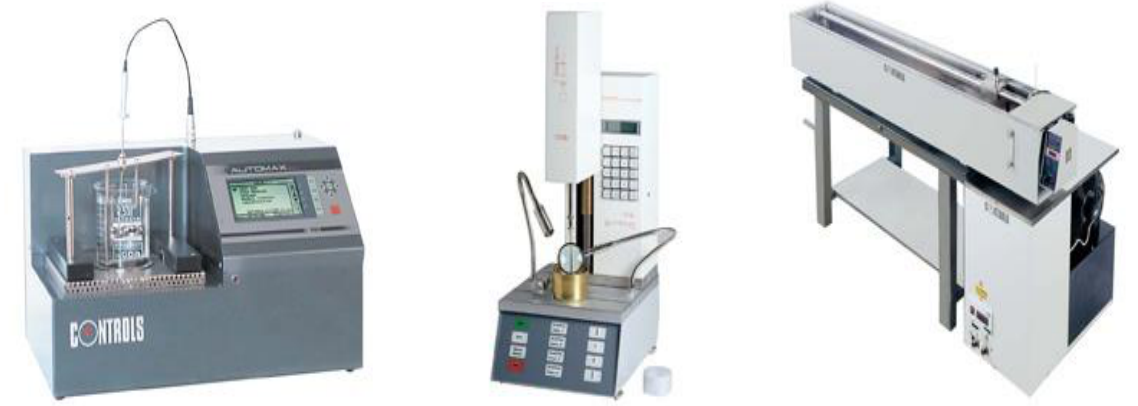
Figure 2. Testing devices from left to right—ring and ball, penetration needle, and ductility device.